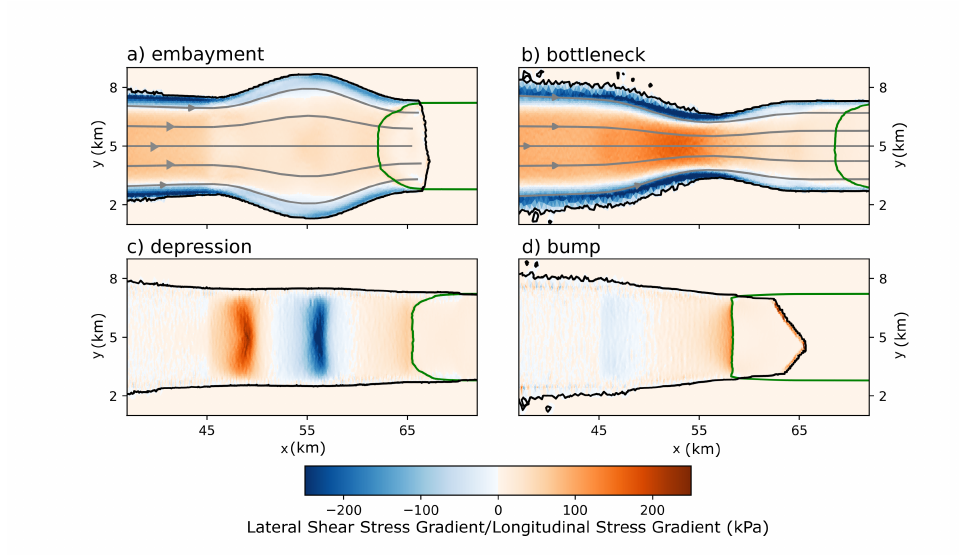
Figure 5. Stress states in perturbations. Lateral shear stress gradients for (a) and (b) , with flow lines in gray, and longitudinal stress gradients for basal perturbations (c, d) . The green line is the grounding line; the black line is the glacier outline.